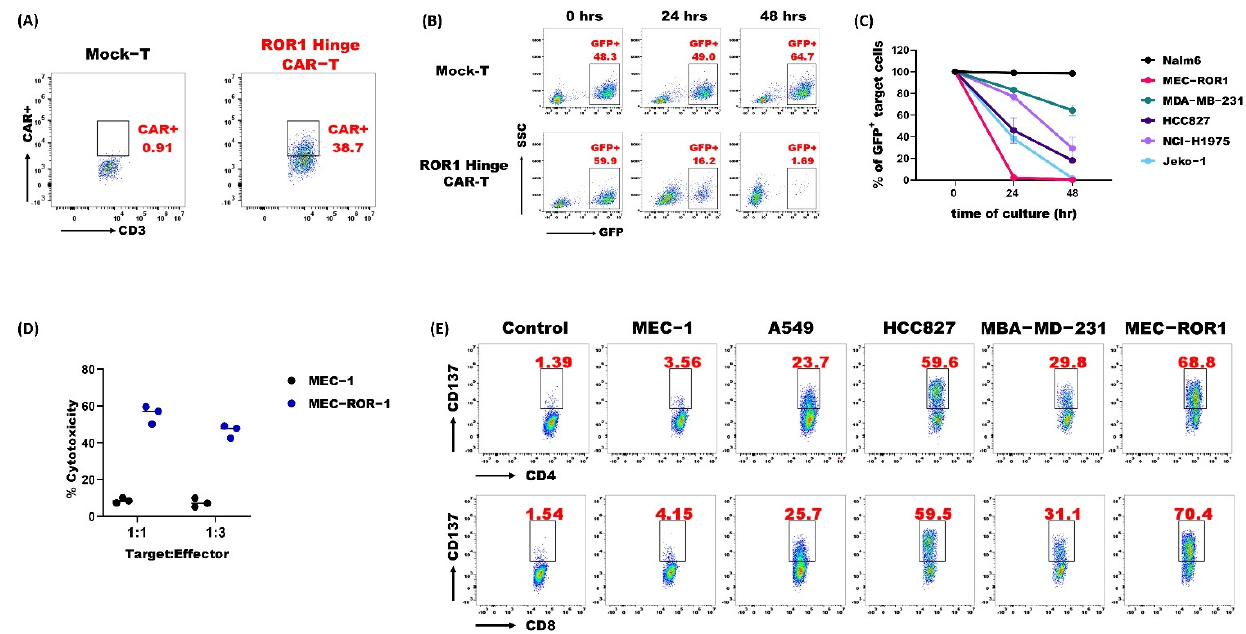
Figure 3. ROR1 Hinge CAR-T-cells show potent in vitro activities against various tumor cell lines. ( A ) The expression of ROR1 Hinge CAR on T-cells that were derived from PBMC at day 5 after lentivirus transduction was detected by flow cytometry; ( B ) Jeko-1 with GFP marker was co-cultured with Mock-T or ROR1 Hinge CAR-T at 1:1 ratio. The population of GFP-expressing cells at 0 h, 24 h, and 48 h were detected by flow cytometry; ( C ) Various cancer cells that express GFP were co − cultured with ROR1 Hinge CAR − T − cells at 1:1 ratio. The GFP − expressing cells were detected by flow cytometry at 0 h, 24 h, and 48 h; ( D ) ROR1 Hinge CAR − T − cells co − cultured with MEC − 1 or MEC − ROR1 and cellular cytotoxicity of CAR − T was determined by LDH cytotoxicity assay at dif-